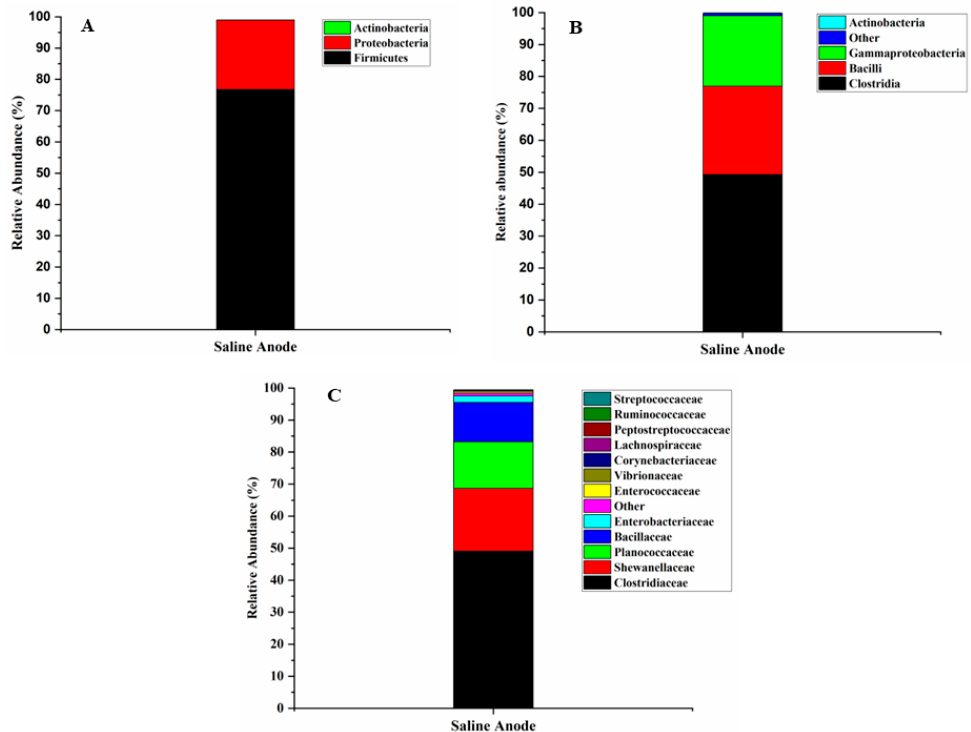
Figure 7. The relative abundance of microbial community at 40 g/L ( A ) Phylum ( B ) Class ( C ) Family Level.